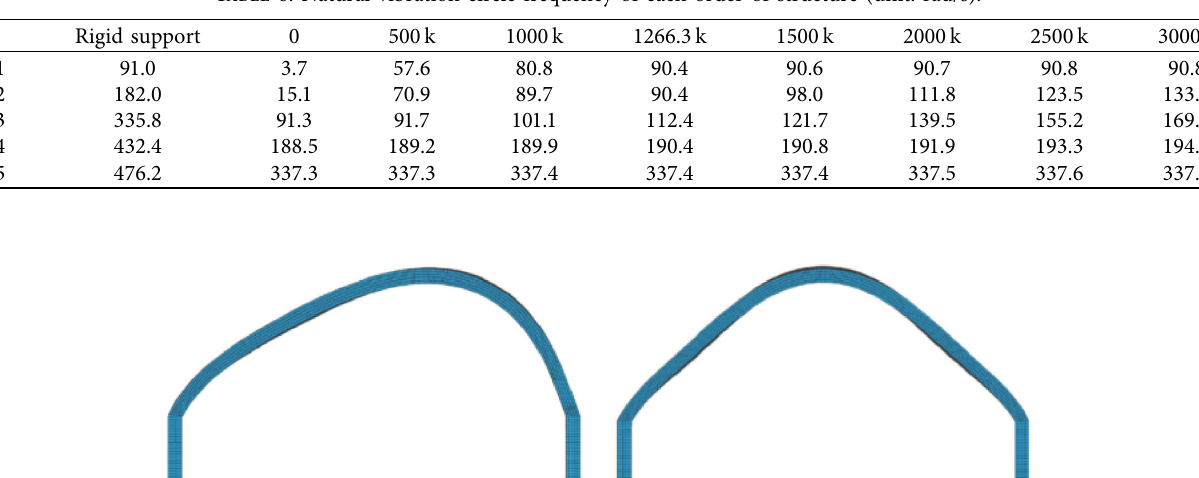
Figure 7: Change of natural vibration circle frequency for arch with elastic support with K . Table 6: Natural vibration circle frequency of each order of structure (unit: rad/s).